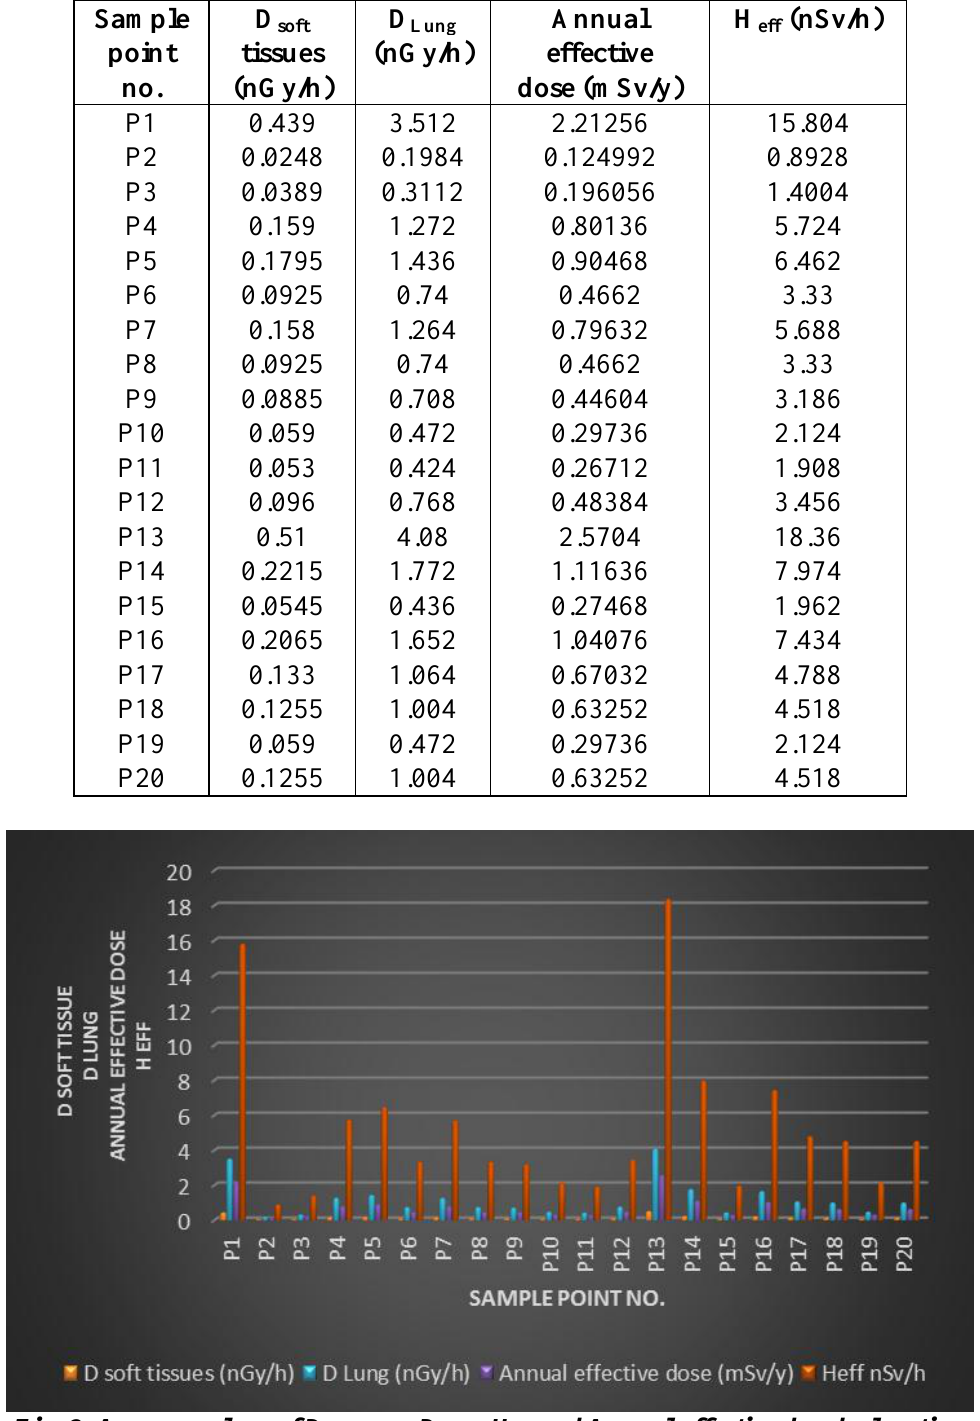
Fig. 6: Average values of D